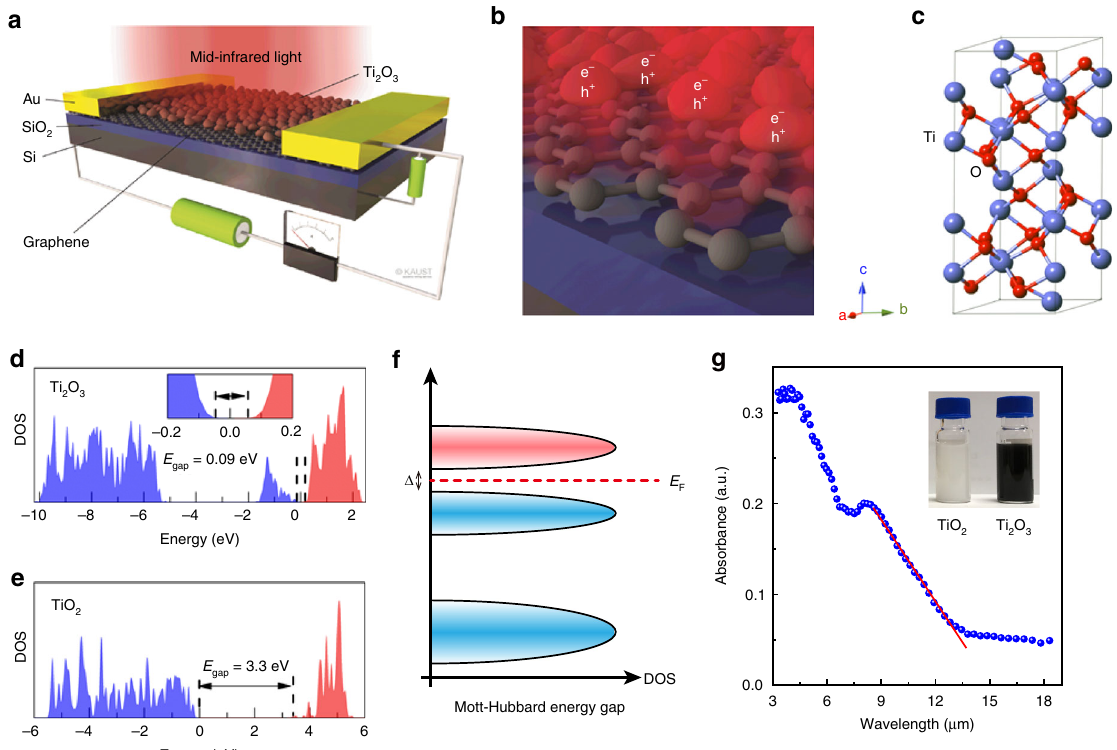
Fig. 1 Hybrid graphene/Ti 2 O 3 nanoparticle mid-infrared photodetector. a A schematic diagram of hybrid graphene/Ti 2 O 3 nanoparticle photodetector. b Illustration of the interface between Ti 2 O 3 nanoparticles and graphene. c Crystal structure of corundum Ti 2 O 3 . d , e Density of states (DOS) of Ti 2 O 3 and TiO 2 derived from fi rst principle calculations, respectively. Blue and red areas represent O 2 p and Ti 3 d orbitals, respectively. f Schematic band diagram of Ti 2 O 3 , indicating that a narrow bandgap is formed between upper Hubbard band (pink) and lower Hubbard band (blue) as a result of strong electron correlation. g Absorption spectrum of Ti 2 O 3 nanoparticles drop-casted on a KBr substrate, measured through Fourier Transform Infrared Spectroscopy. The cut-off wavelength is about 13.3 µ m, which corresponds to a band gap of 0.09 eV. The inset is a photo of TiO 2 and in Ti 2 O 3 nanoparticles in